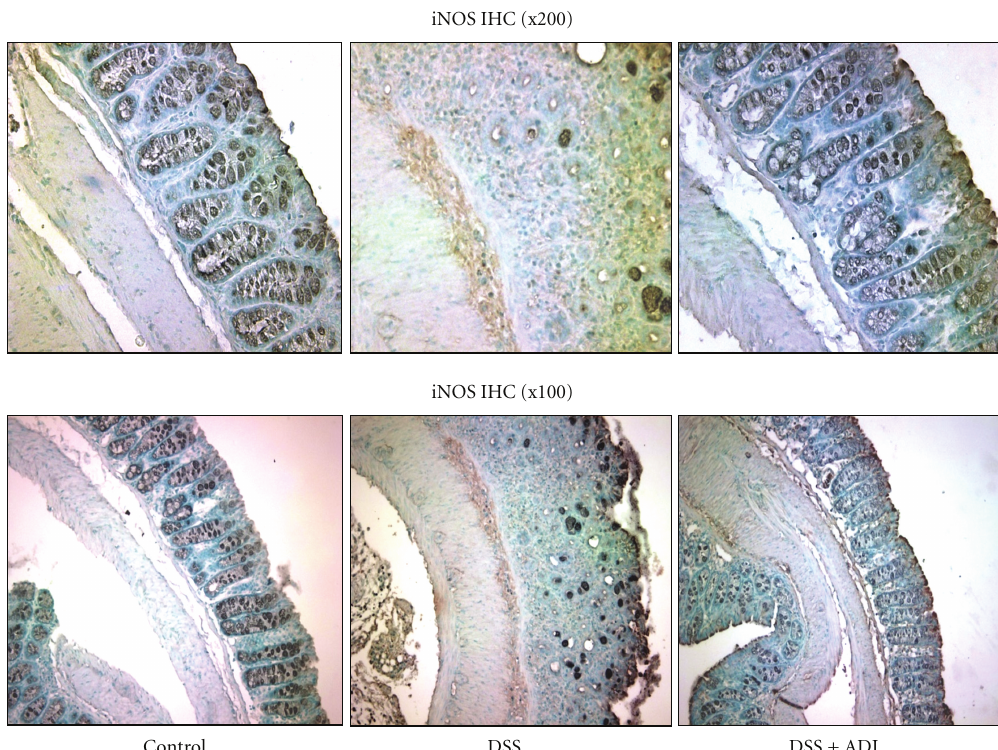
Figure 4: E ff ect of ADI-PEG on macrophage infiltration in colonic tissue from colitic IL-10-deficient mice. ADI-PEG markedly decreased submucosal macrophage infiltration and iNOS expression in DSS-induced colitic IL-10-deficient as well as WT mice (not shown). ( n =